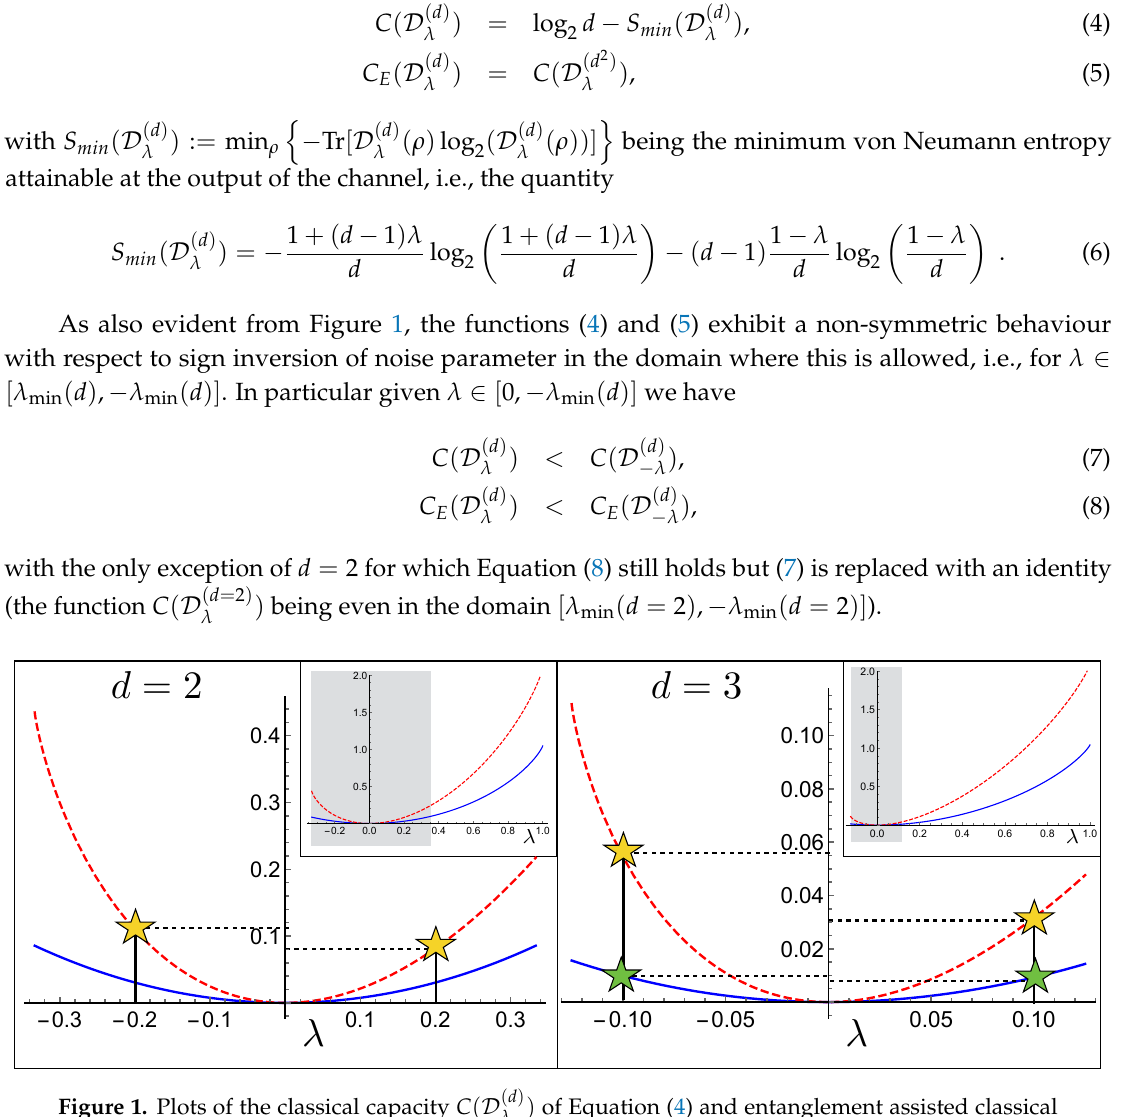
) of Equation (4) and entanglement assisted classical Figure 1. Plots of the classical capacity C ( D ( d ) λ ) of Equation (5) as a function of the noise parameter λ belonging to the interval of capacity C E ( D ( d ) λ interest [ λ min ( d ) , − λ min ( d )] , for d = 2 (left panel) and d = 3 (right panel). Notice the asymmetric ) and C ( D ( d = 3 ) ) (the classical capacity C ( D ( d = 2 ) ) instead is symmetric). The behaviour of C E ( D ( d ) λ λ λ d insets show the capacity for the full range of λ . All the curves have being rescaled by log 2